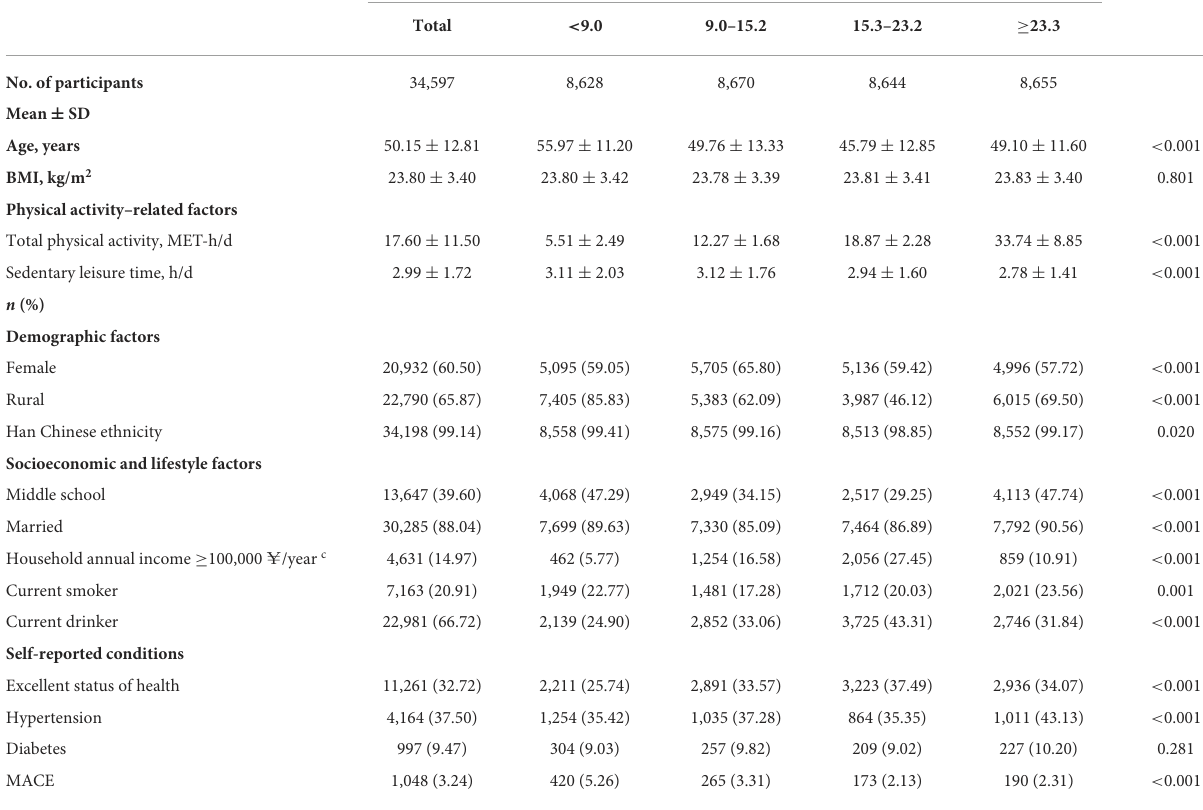
TABLE 1 Characteristics of Shaanxi Province people by levels of physical activity a .